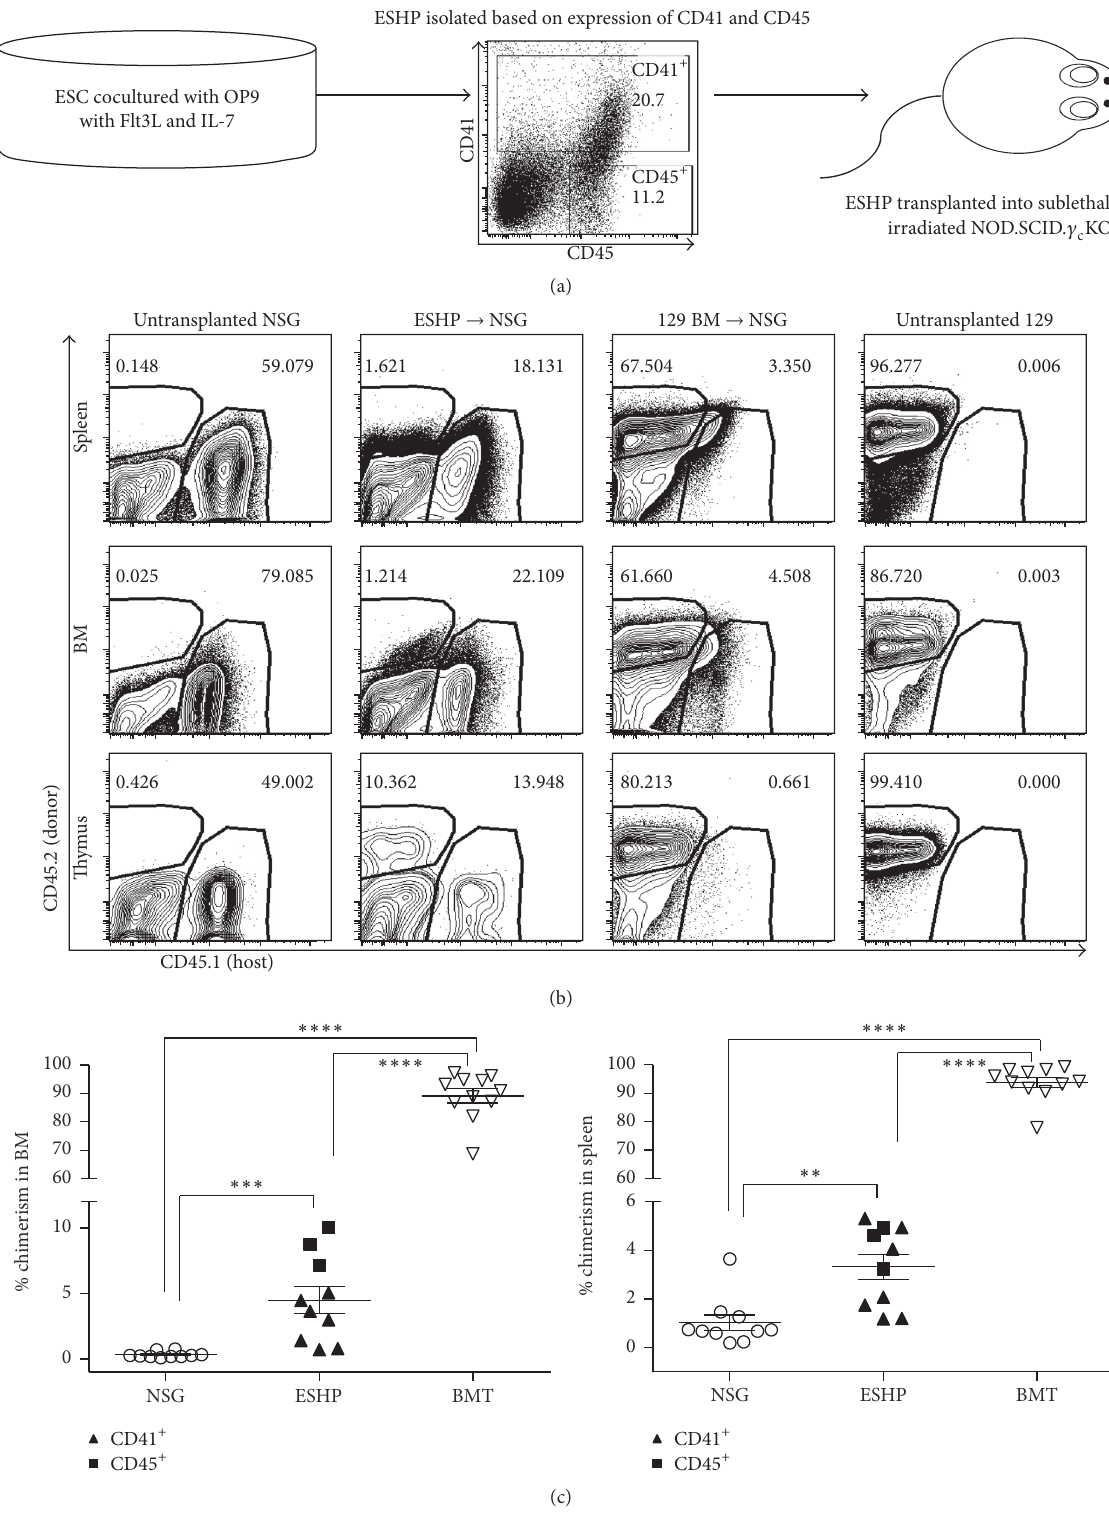
Figure 1: Generation of hematopoietic chimeras using ESHPs. (a) Schematic outline of ESHP generation, isolation, and transplantation. (b) Flow cytometry of hematopoietic chimerism using CD45.2 (donor) on 𝑦 -axis and CD45.1 (host) on 𝑥 -axis in spleen (top), BM (middle), and thymus (bottom). (c) Percent chimerism of total hematopoietic cells in BM (left) and spleen (right) of ESHP recipients (top row) and whole BMT controls (bottom row). Chimerism resulting from transplantation of sorted CD41 + ESHP and CD45 + ESHP is combined on the graph and for statistical analysis (CD41 filled triangles ( 𝑛 = 7 ), CD45 filled squares ( 𝑛 = 3 ), untransplanted NSG (open circles, 𝑛 = 10 ), and BMT recipients (open squares, 𝑛 = 11 )). Bars represent mean ± SEM; ∗∗ 𝑝 < 0.01 ; ∗∗∗ 𝑝 < 0.001 ; ∗∗∗∗ 𝑝 < 0.0001